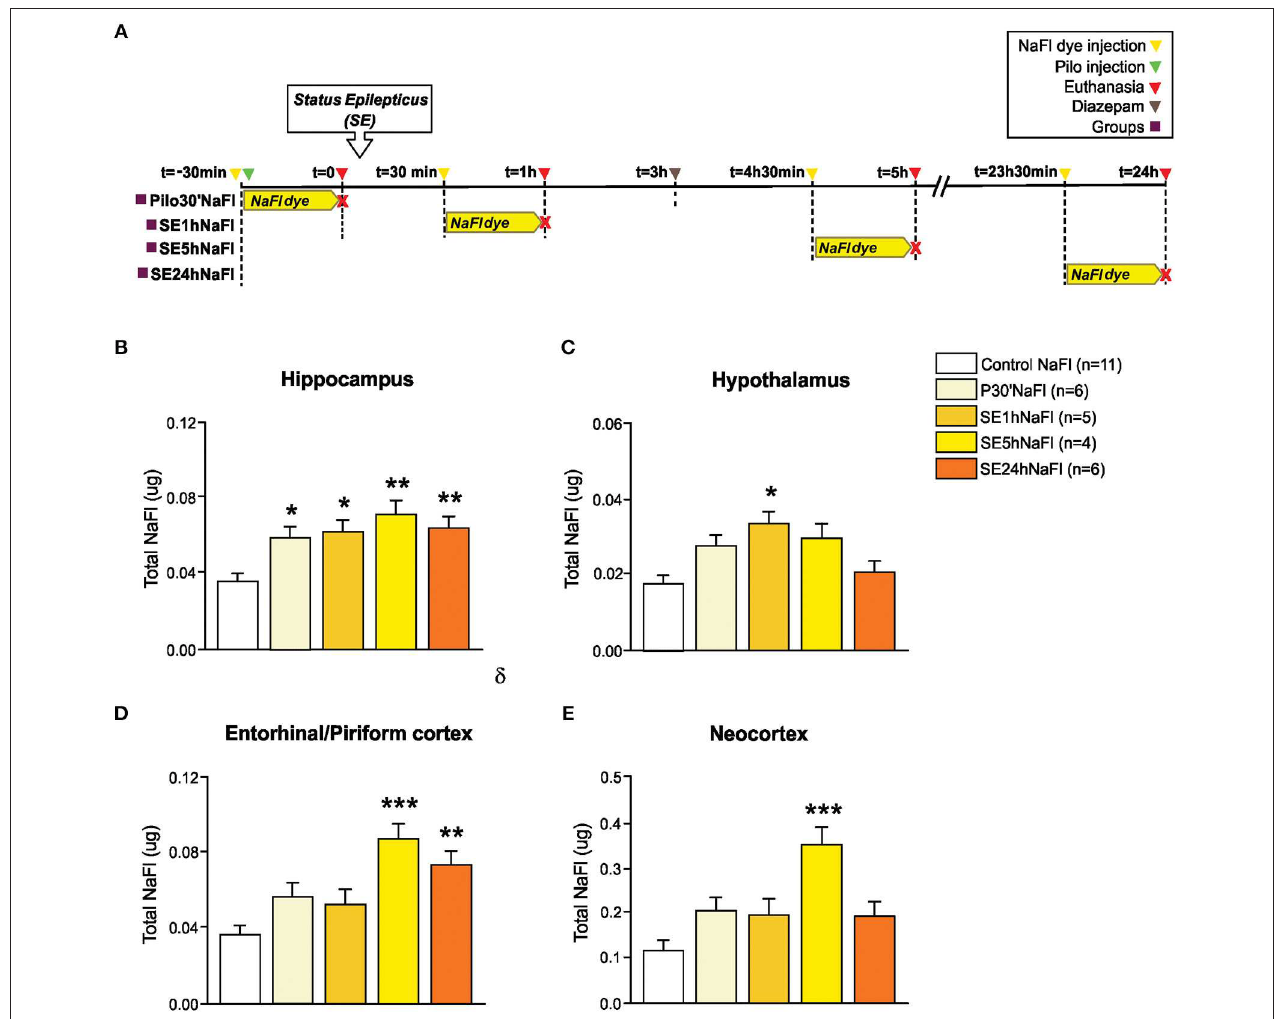
FIGURE 1 | Increased permeability of the BBB to the NaFl dye during the acute phase of the pilocarpine model of epilepsy. In (A) , a schematic representation of the experimental design for evaluation of the BBB permeability to micromolecules: in the Pilo30’NaFl group, the NaFl dye was intravenously injected immediately before the pilocarpine (i.p.), and the animals were euthanized 30min after PILO-injection. In the SE1hNaFl group, the NaFl dye was injected 30min after the beginning of the status epilepticus (SE), and the animals were euthanized 1h after SE onset. In the SE5hNaFl group, the NaFl dye was injected 4h 30min after the beginning of the SE, and the animals euthanized 5h after SE onset. In the SE24hNaFl group, the NaFl dye was injected at 23h 30min after the beginning of the SE, and the animals were euthanized 24h after SE onset. Note that rats from SE5hNaFl and SE24hNaFl groups had the seizures blocked with diazepam 3h after SE initiation. In (B–E) , quantitative analysis shows that BBB tracer NaFl dye can be detected since the initial periods of the acute phase of the pilocarpine model in the hippocampus (B) , hypothalamus (C) , entorhinal/piriform cortex (D) , and neocortex (E) . Data expressed as mean ± SEM. * p < 0.05, ** p < 0.01, *** p < 0.001 in comparison with control groups by one-way ANCOVA (mass of the region as covariate) and Sidak post-hoc